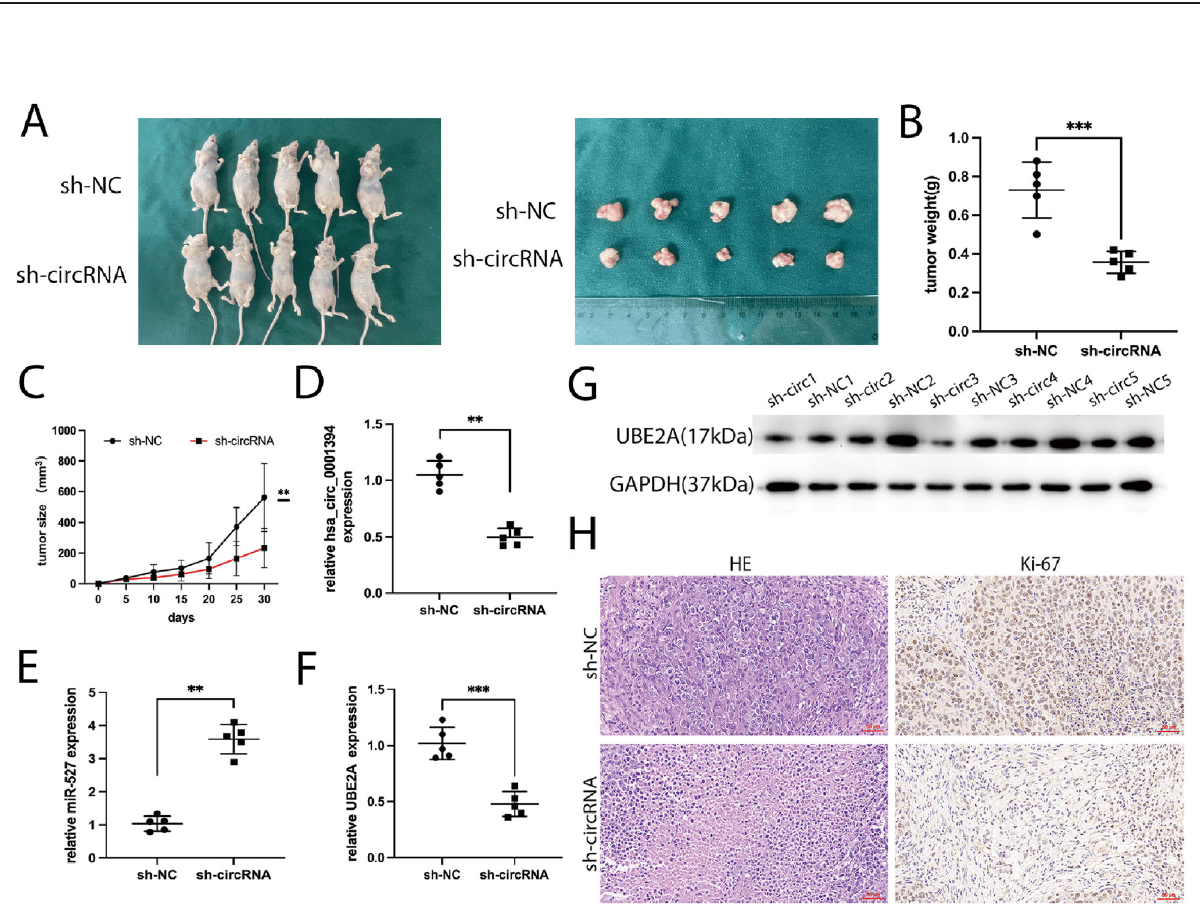
Fig. 7 Knockdown of hsa_circ_0001394 suppresses HCC progression in vivo. A Five pairs of nude mice were subcutaneously injected with Huh7 cells transfected with sh-NC or sh-circRNA plasmids. After 30 days, HCC tumors were dissected and photographed. B Tumor weight was calculated on the day mice were euthanized. The tumor weight of hsa_circ_0001394-de fi cient group was markedly lower than that of the control group. C Tumor volumes were recorded every 5 days starting on the day when mice were inoculated with Huh7 cells transfected with sh-NC or sh-circRNA. Hsa_circ_0001394 knockdown decreased tumor volumes relative to the control group. D Hsa_circ_0001394 was downregulated in the hsa_circ_0001394-de fi cient group relative to the control group according to qRT-PCR. E MiR-527 was upregulated in the sh-circRNA group compared to the control group according to qRT-PCR. F UBE2A was signi fi cantly expressed at lower levels in the hsa_circ_0001394 knockdown group than in the control group as determined by qRT-PCR. G The protein levels of UBE2A were compared between the sh-NC nude mouse models and sh-circRNA models using western blot analysis. Hsa_circ_0001394 silencing reduced the protein levels of UBE2A. H Representative images of hematoxylin – eosin (HE) staining of sections of xenograft tumors formed by Huh7 cells. Ki-67 staining of tumors was determined by immunohistochemical analysis. All values are presented as mean ± SD from three independent experiments with similar results. (* p < 0.05, ** p < 0.01, *** p < 0.001).